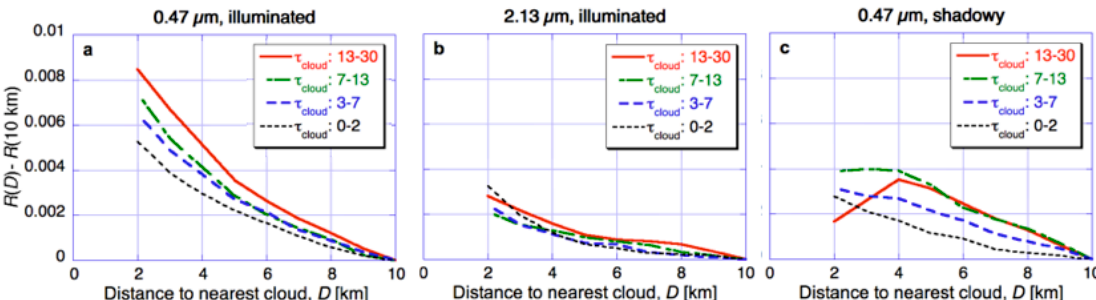
Figure 5. Dependence of MODIS clear-sky reflectance enhancements on cloud optical thickness ( τ cloud ). ( a ) and ( b ) Mean 0.47 µm and 2.13 µm reflectance of pixels that are on the sunlit side of the nearest cloud ( c ) Mean 0.47 µm reflectance of pixels that are on the shadowy side of the nearest cloud. The